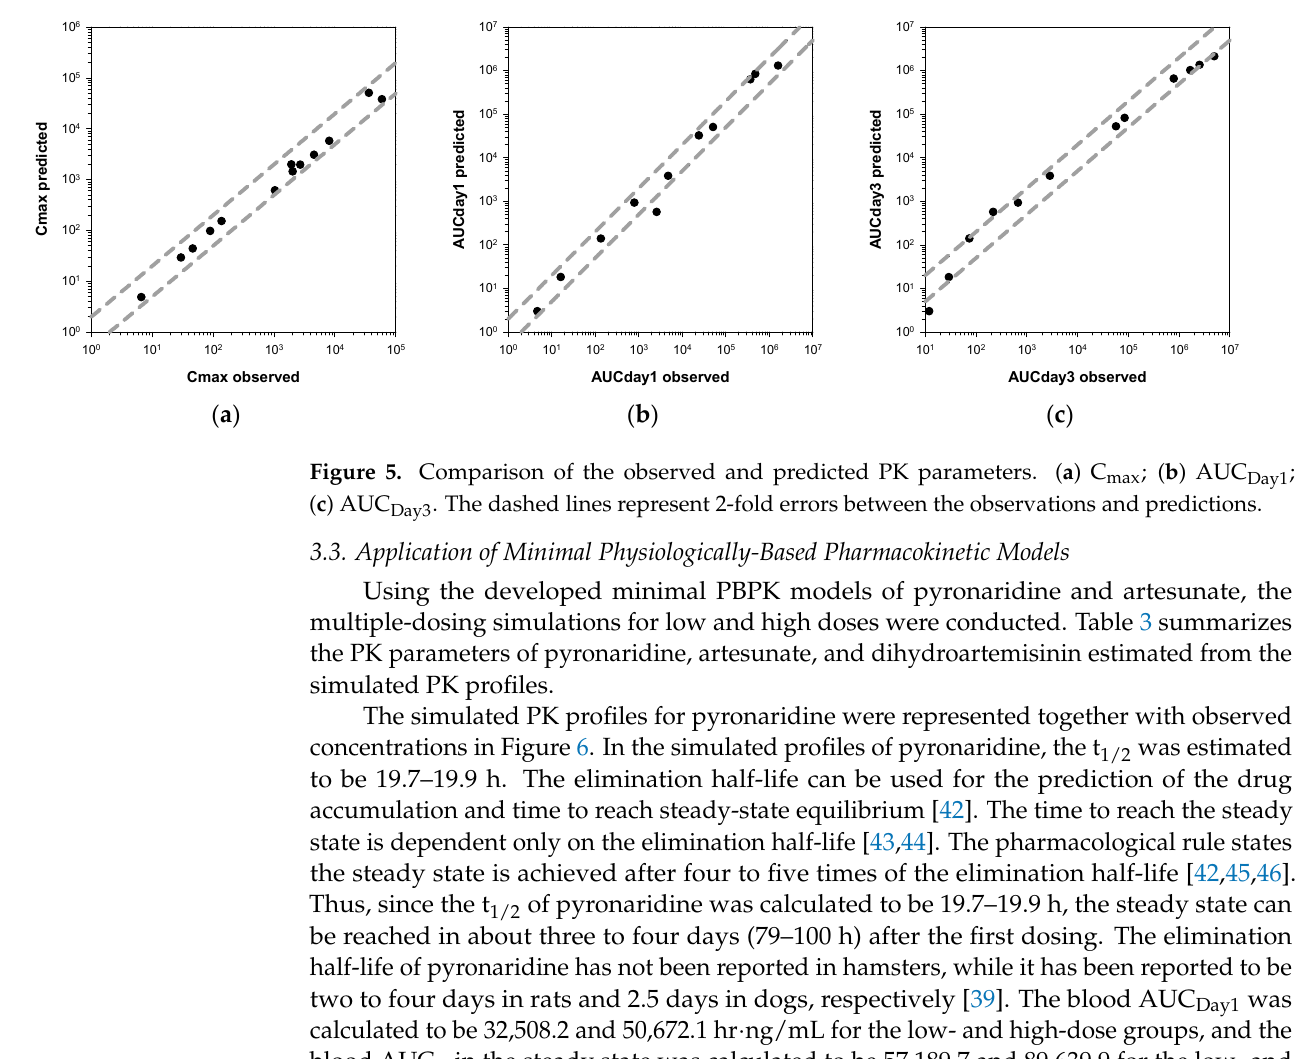
Figure 4. Normalized sensitivity coefficients for the minimal PBPK models of pyronaridine and ar- tesunate. ( a ) pyronaridine; ( b ) artesunate; ( c ) dihydroartemisinin. The fold errors (FEs) for C max , AUC Day1 , and AUC Day3 for the three compounds were calculated to evaluate the accuracy of the model predictions (Figure 5). The percentage of PK parameters that were within a twofold error was 100% for C max , 91% for AUC Day1 , and 75% for AUC Day3 , respectively. The average fold errors (AFEs) for C max , AUC Day1 , and AUC Day3 were calculated to be 0.84, 0.94, and 0.86, respectively. Most of the FEs and all of the AFEs for PK parameters were under the twofold limit, suggesting the good predictive performances of the minimal PBPK models.